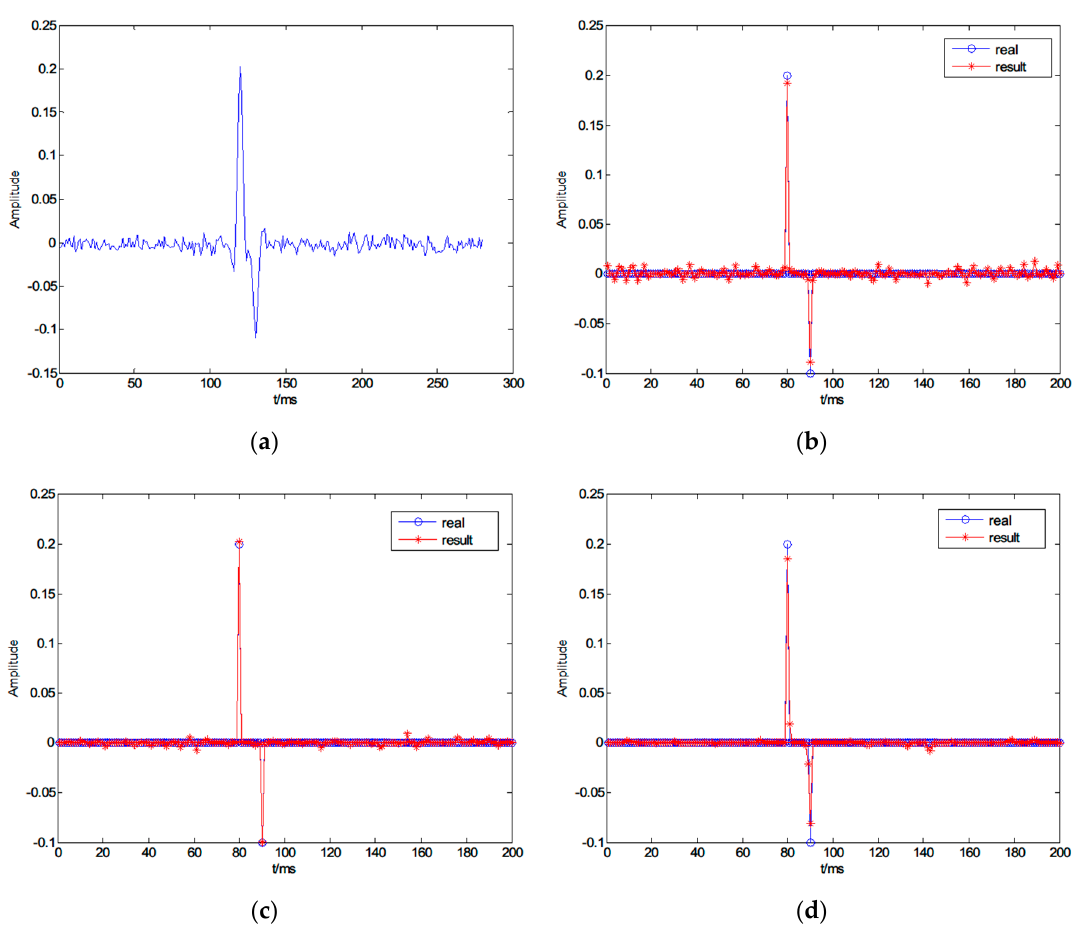
Figure 9. Influence of the dominant frequency band on the inversion result. ( a ) Synthetic seismic trace; ( b ) inversion result using 5–100 Hz as the dominant frequency band; ( c ) inversion result using 5–80 Hz as the dominant frequency band; and ( d ) inversion result using 5–40 Hz as the dominant frequency band.